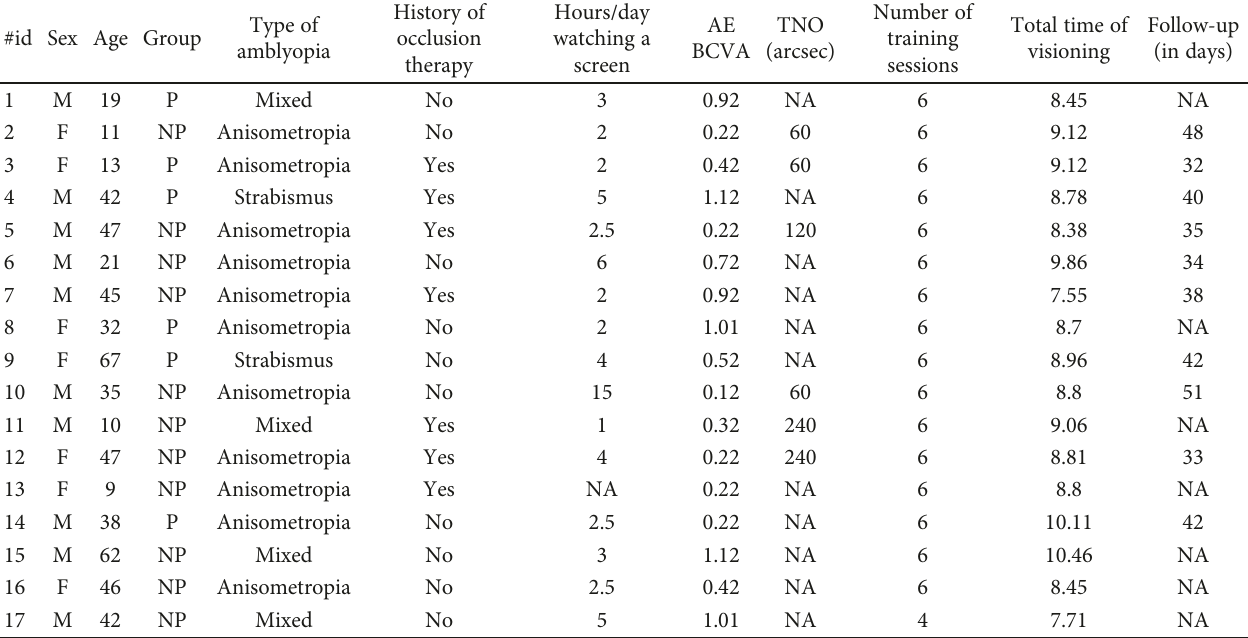
Table 1: Characteristics of amblyopic